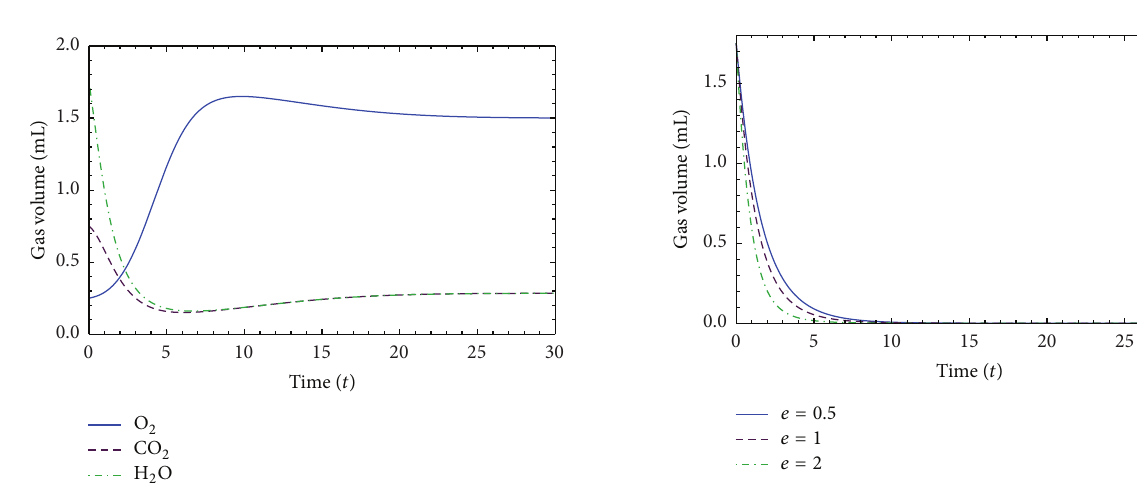
Figure 4: This figure shows the stability of both 𝐸 2 and 𝐸 4 . We choose the parameters 𝑎 = 0.6 , 𝐾 = 1.9 , 𝑢 = 1 , 𝑓 = 0.5 , 𝑠 = 1 , 𝑒 = 0.5 , and ℎ = 1 .